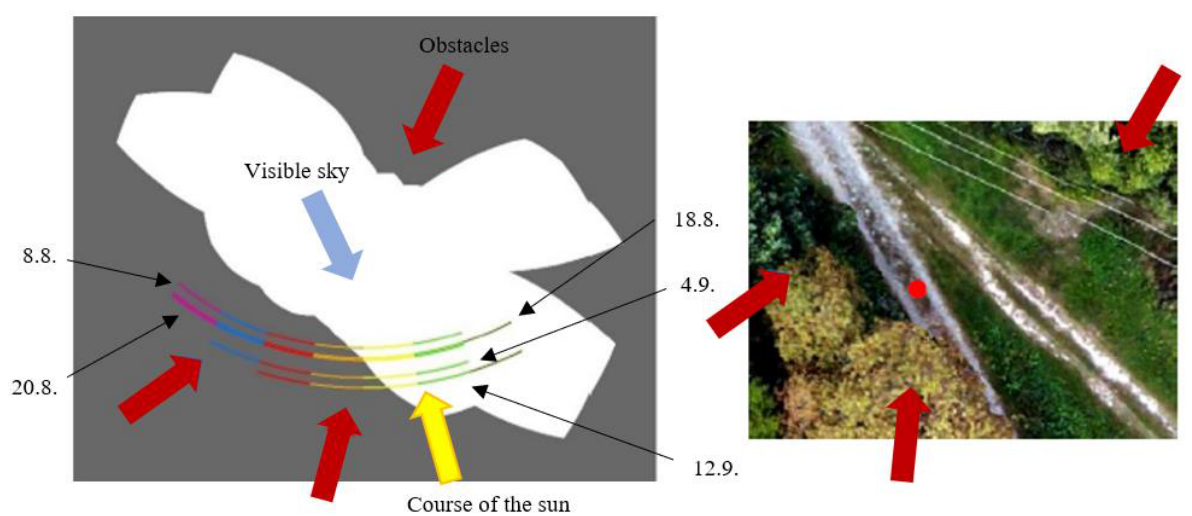
Figure 4. Shading of the horizon and the course of the sun. In the figures showing the shading of the horizon above a given point, grey indicates the shading and white means the visible horizon or sunlight. The coloured semicircles mark the course of the sun across the sky during the selected day, which is marked with different colours after each hour. The individual protrusions in grey indicate obstacles (red arrows) that prevent the rays of light from passing to the measured point. These are trees and shrubs that can be recognised when compared to the attached RGB images.